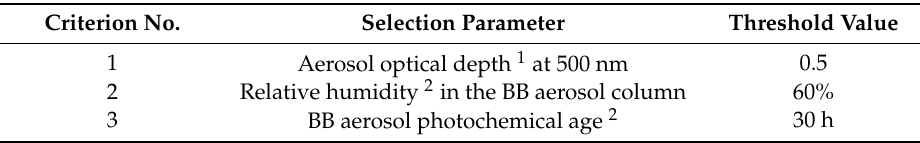
Table 1. Selection criteria applied to the AERONET observations. BB, biomass burning. Criterion No. Selection